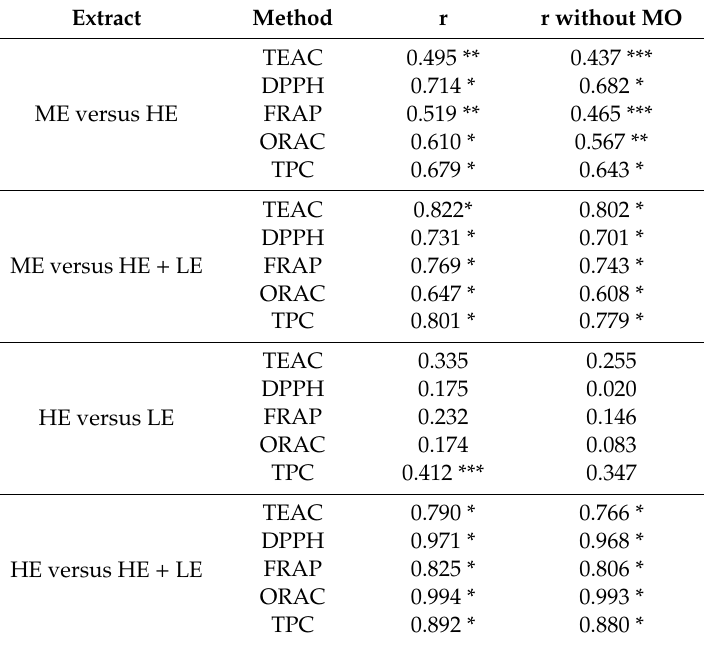
Table 4. Correlations between values obtained by di ff erent extraction procedures in similar methods of analysis with, and without, Moringa oleifera (MO) (* p < 0.001; ** p < 0.01; *** p < 0.05). Extract